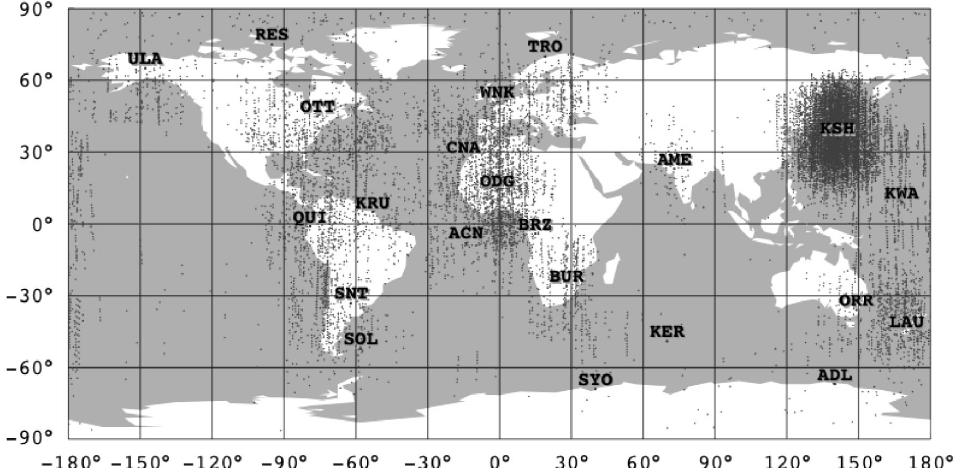
Fig. 18.10. Geographical distribution of the available profiles: ISIS-2 satellite.